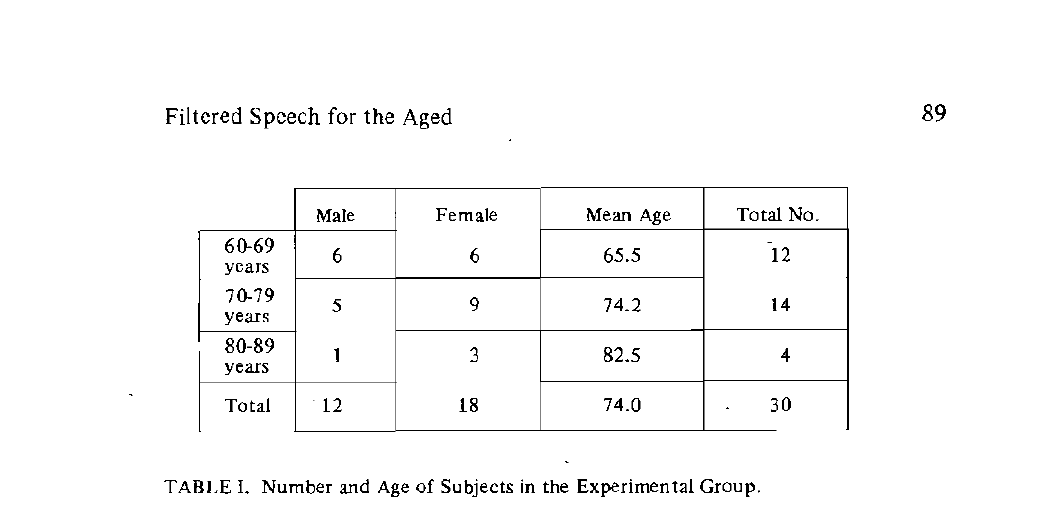
TABLE I. Number and Age of Subjects in the Experimental Group.